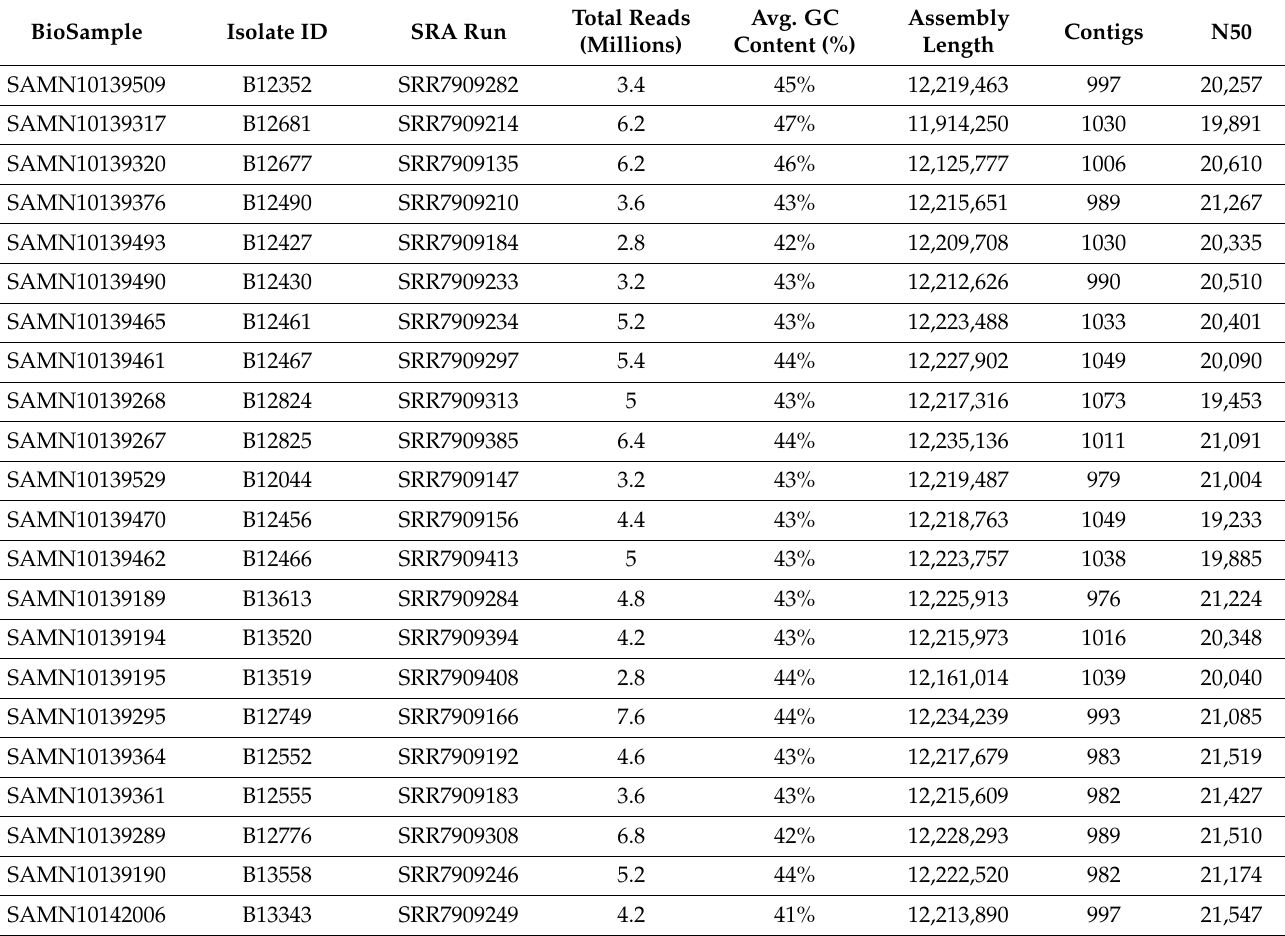
Table 2. Candida auris whole-genome sequence benchmark dataset sequence